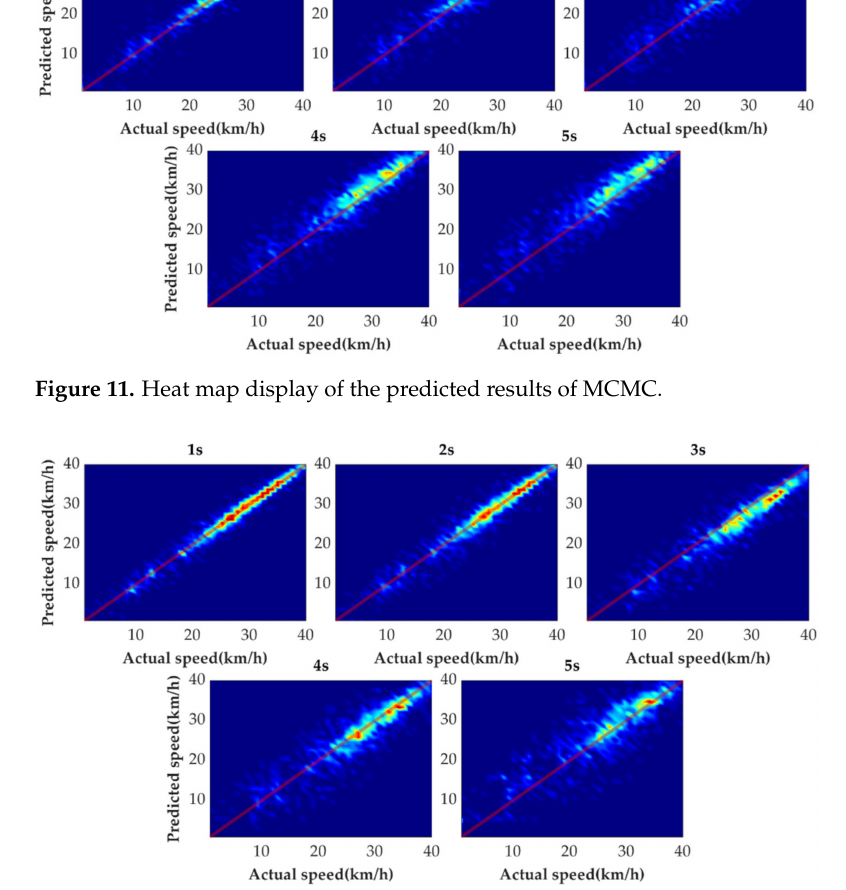
Figure 12. Heat map display of the predicted results of